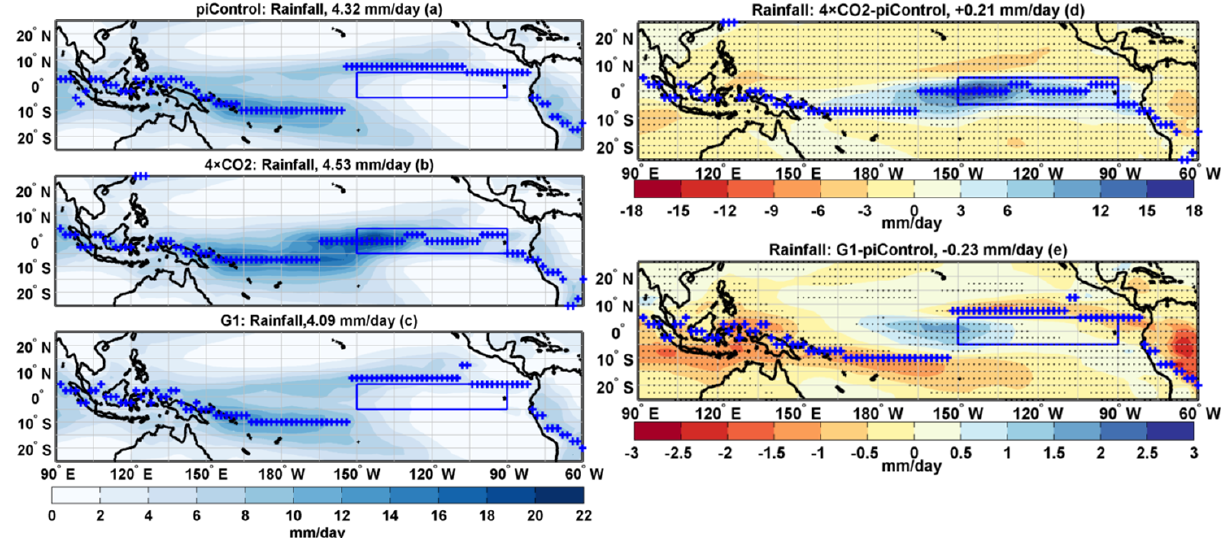
Figure 2. Tropical Pacific rainfall mean DJF climatology: (a) piControl, (b) 4 × CO 2 , (c) G1, (d) 4 × CO 2 − piControl difference (the blue plus signs indicate the position of the ITCZ under 4 × CO 2 ), and (e) G1 − piControl (the blue plus signs indicate the position of ITCZ under G1). In (a) – (c) , the blue plus signs indicate the position of ITCZ for the corresponding experiment. Stipples indicate grid points where the difference is statistically significant at 99%cl using a non-parametric Wilcoxon rank-sum test. The numbers in (a) – (c) represent mean rainfall in the corresponding simulation, and numbers in (d) – (e) represent an area-averaged difference in piControl with 4 × CO 2 and G1, respectively, in the tropical Pacific region (25 ◦ N–25 ◦ S, 90 ◦ E–60 ◦